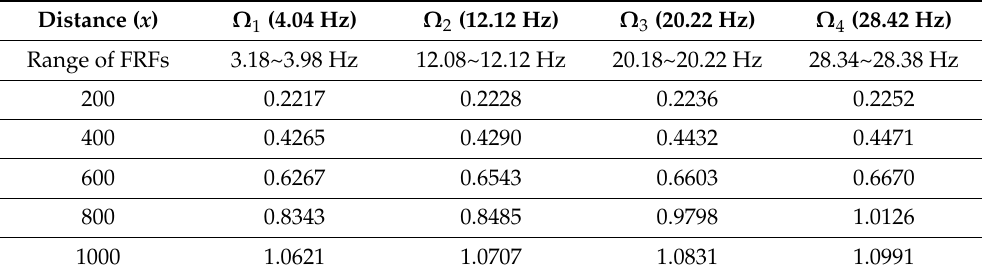
Table 2. Summary of the impact hammer test on a cantilevered